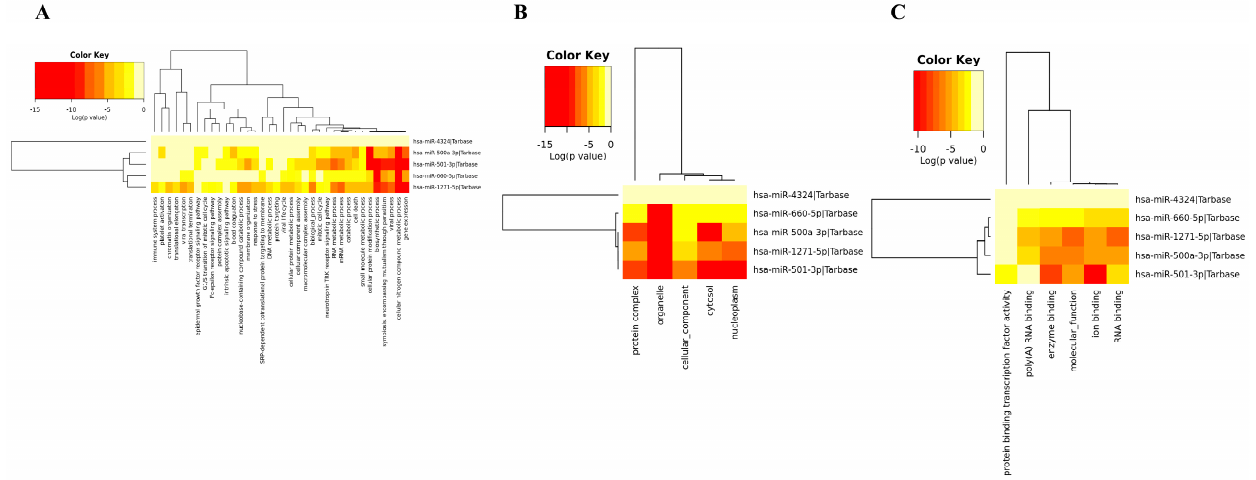
Figure 5. Gene ontology of downregulated miRNAs. ( A ) Biological processes. ( B ) Cellular compo- nents. ( C ) Molecular functions.